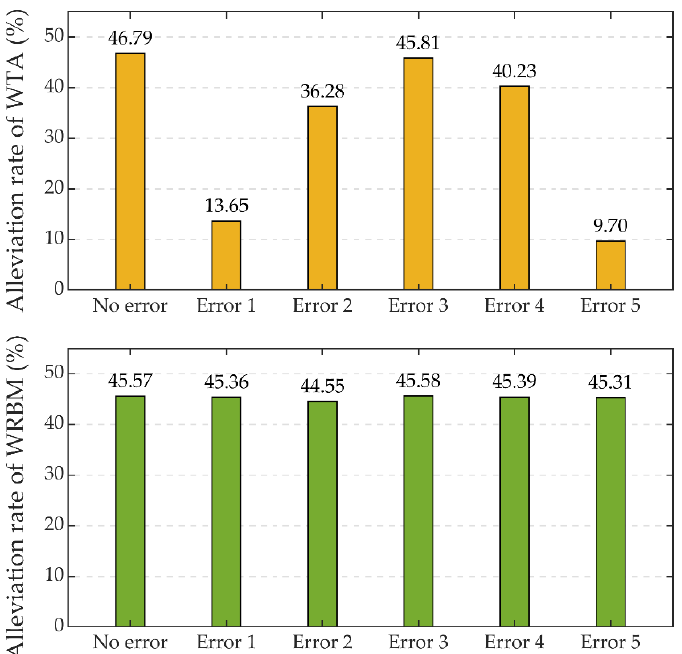
Figure 18. Influence of sensor errors on gust alleviation rate.